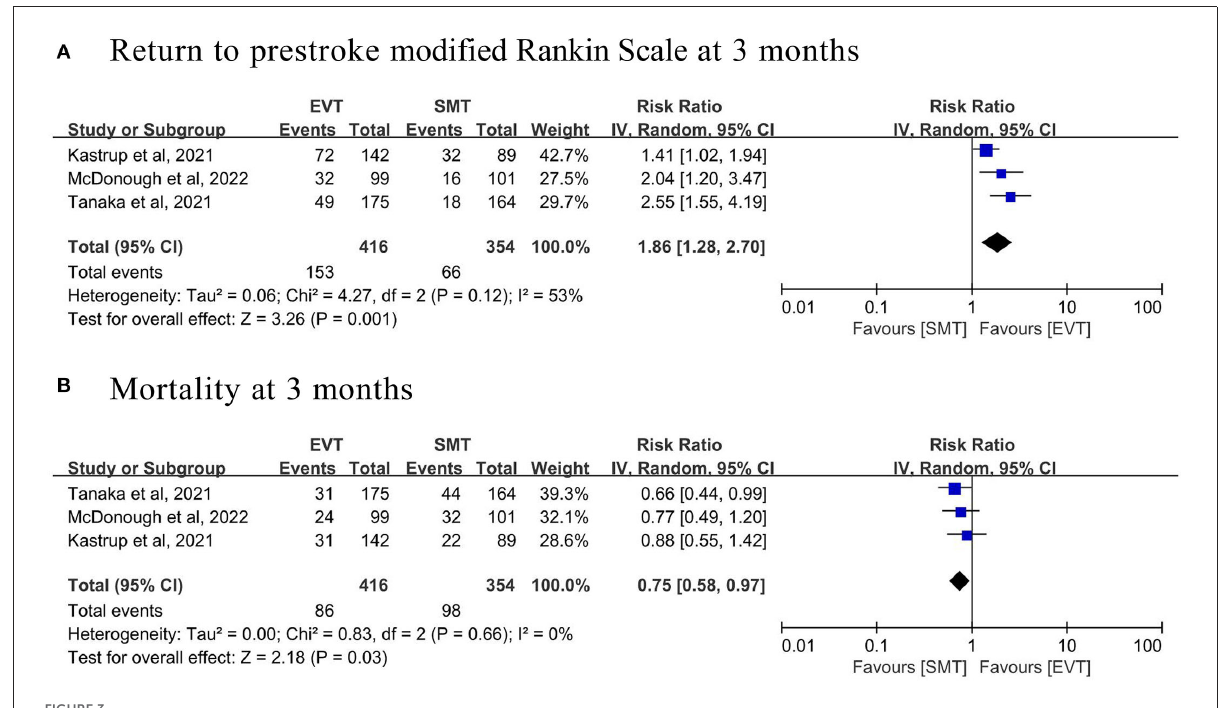
FIGURE3 Forest plot of (A) return to prestroke modified Rankin Scale and (B) mortality at 3 months in prestroke disability patients treated with endovascular thrombectomy (EVT) vs. standard medical therapy (SMT).